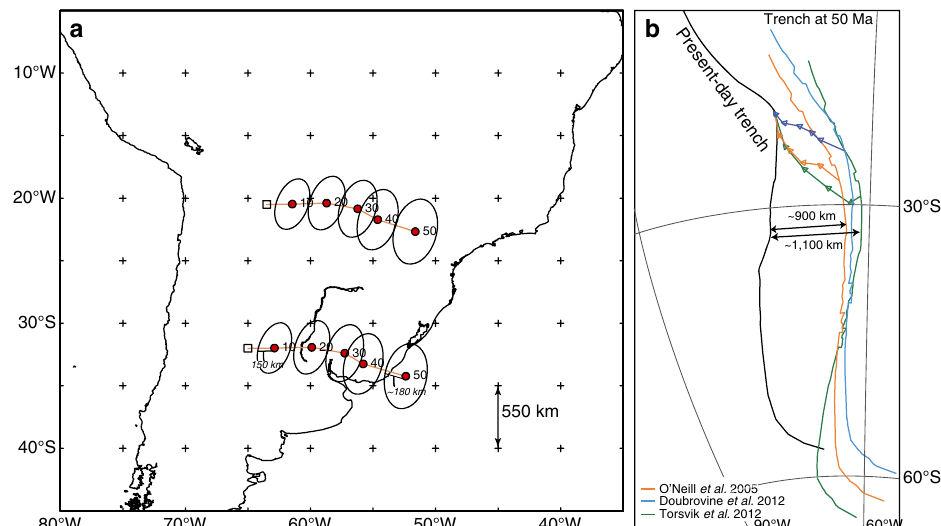
Figure 6 | Absolute plate motions and trench retreat estimates. ( a ) Absolute plate motion track of South America estimated from the global moving hotspot reference frame of Doubrovine et al. 25 , including error bars. These estimates lie at the basis of our analysis of Andean trench retreat since 50Ma. ( b ) Absolute trench retreat estimates, based on combining our estimate of Andean shortening with absolute plate motion models for South America, based on the moving hotspot reference frames of Doubrovine et al. 25 (preferred), Torsvik et al. 35 and O’Neill et al. 36 . The latter two frames would predict 100km higher or lower trench retreat, within error of the Doubrovine et al. 25 frame.